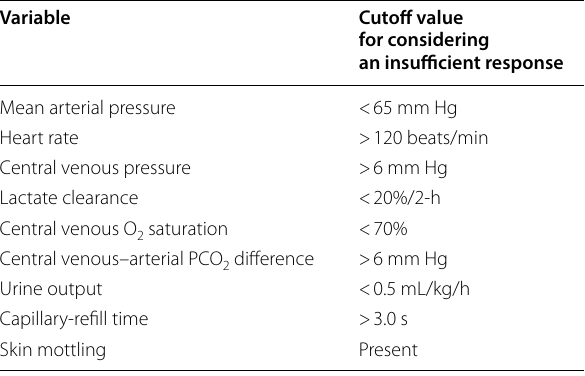
Table 1 Variables used to assess the response to the initial fluid bolus of 30 mL/kg